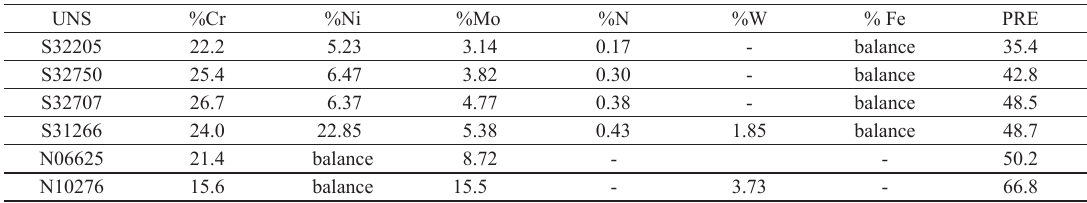
Table 1. Summary of the chemical composition of the materials studied (% by mass) and PRE.